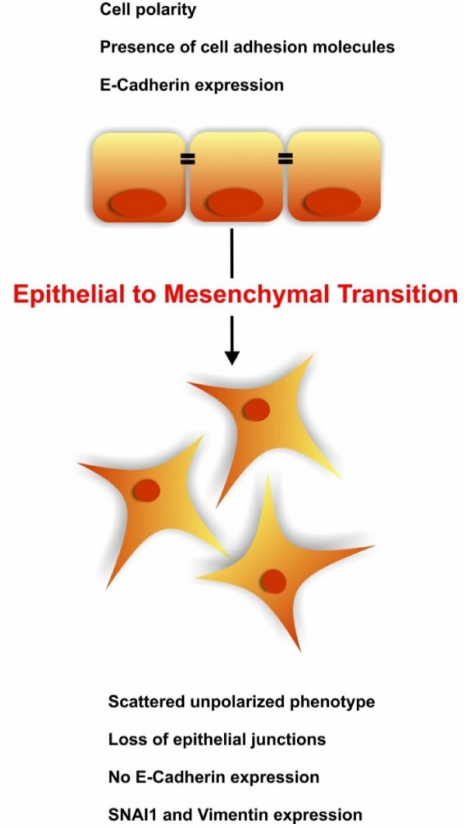
Figure 1. Epithelial to Mesenchymal transition. During Epithelial to Mesenchymal transition (EMT), epithelial cells lose their organized phenotype and gain a scattered mesenchymal phenotype. This transition can be caused by various growth factors and is characterized by loss of polarization, tight junctional integrity, and E-Cadherin expression. The epithelial cells undergoing EMT acquire a fibroblastic appearance, increased motility and de novo expression of SNAI1, Vimentin, α -SMA, and